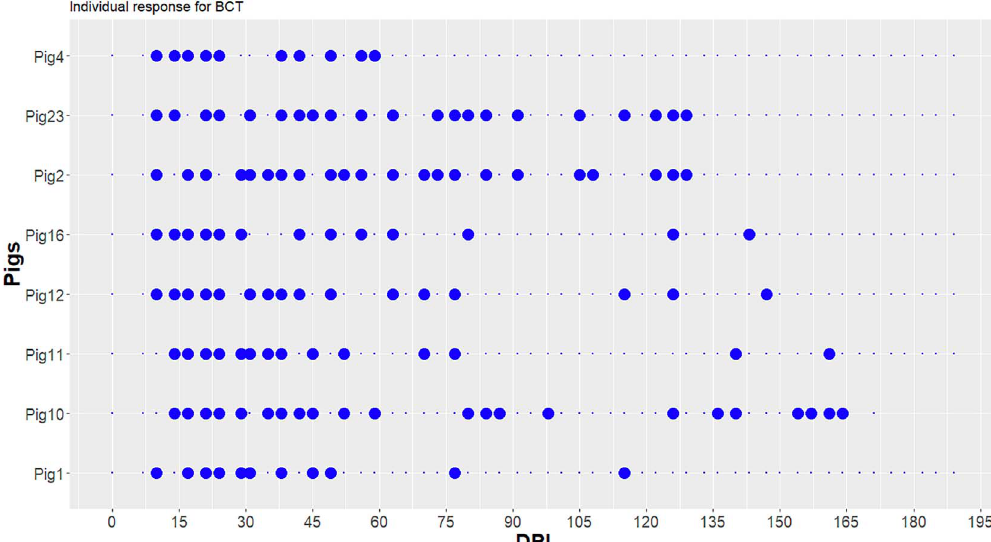
Figure 1. Individual buffy coat technique (BCT) results of the infected pigs during the experiment. Large blue point: BCT positive; small blue point: BCT negative; dpi: days post infection.